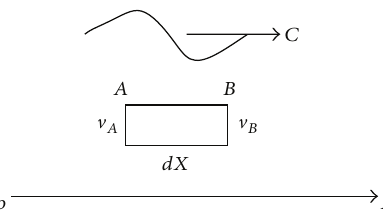
Figure 1: Strain rate analysis of stress wave transmission medium.